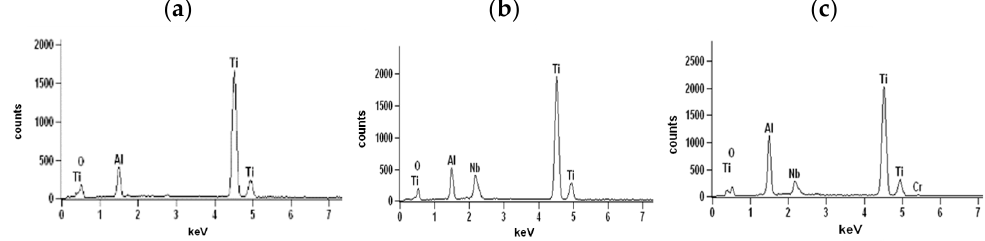
Figure 14. EDS analysis: ( a ) in area 1, ( b ) in area 2 and ( c ) in area 3 marked in Figure 12.